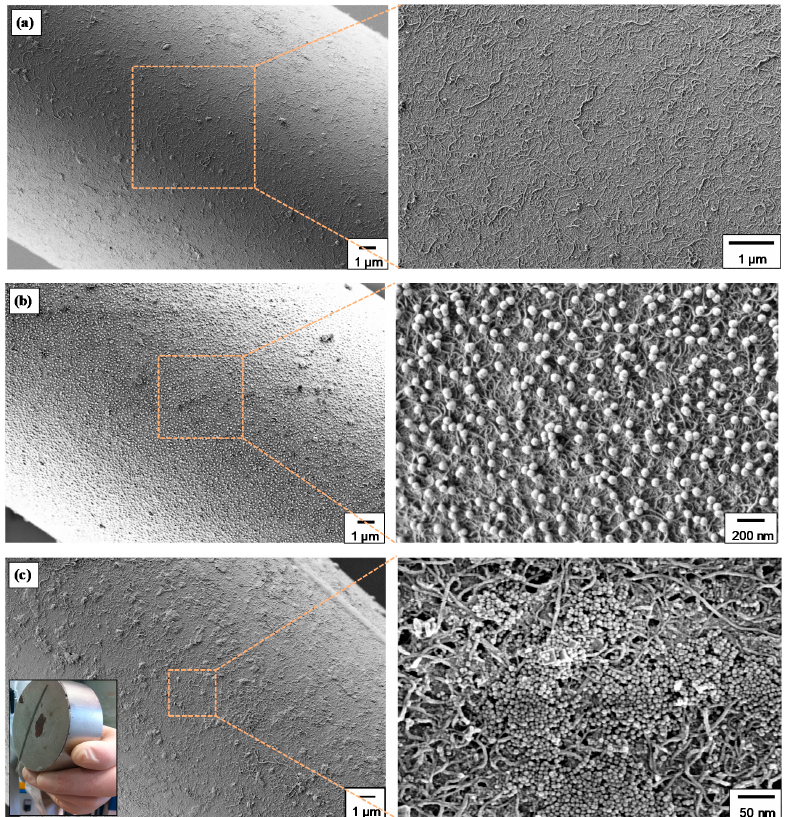
Figure 5. FE-SEM images of single ( a ) GFs grafted with MWCNTs (GF-CNT), ( b ) GF-CNT/SiO 2 and ( c ) GF-CNT/ Fe 3 O 4 hierarchical reinforcements, at two different magnifications (inset in Figure 5c: the magnetic response of a GF-CNT/Fe 3 O 4 tow).